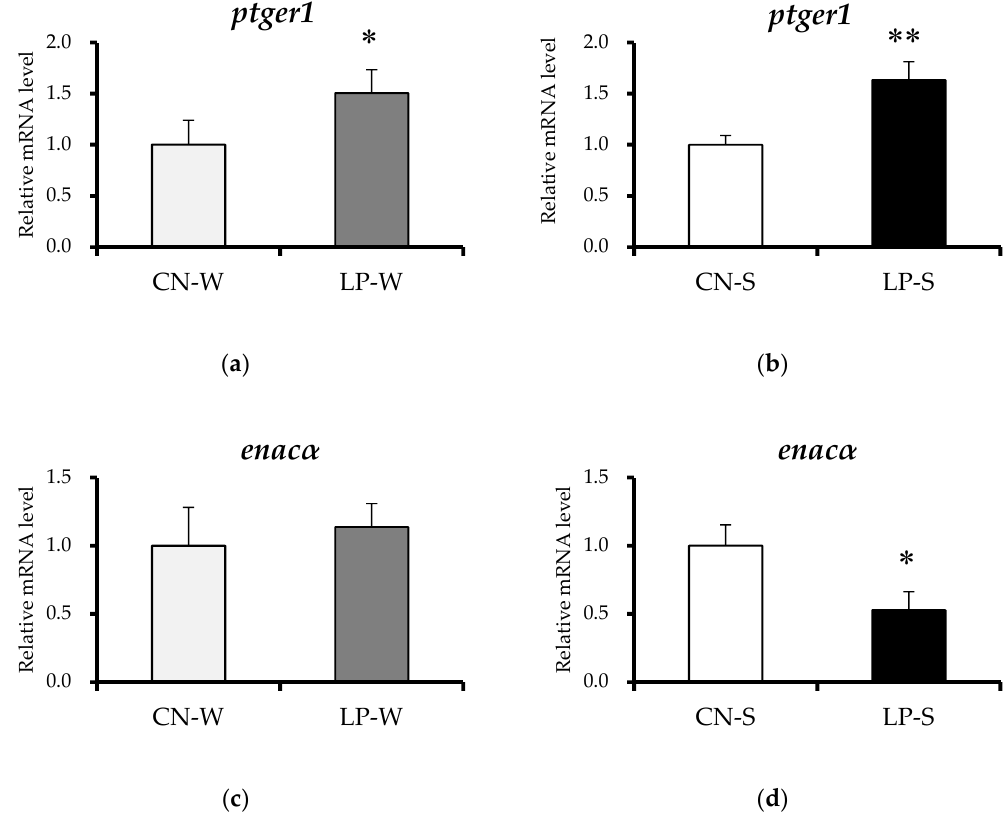
Figure 4. Relative renal expression of ptger1 and enacα mRNA. ( a ) ptger1 mRNA expression levels (Animal experiment 1). ( b ) ptger1 mRNA expression levels (Animal Experiment 2). ( c ) enacα mRNA expression levels (Animal Experiment 1). ( d ) enacα mRNA expression levels (Animal Experiment 2). Values are expressed as the mean ± standard error ( n = 7–8). ** p < 0.01, * p < 0.05 vs. the CN-W or CN-S offspring according to a Student’s t -test. Offspring were exposed to either an intrauterine environment of 20% (CN)-feeding mothers or that of 9% (LP)-Casein diet-feeding mothers, and provided with either water (W) or 1% saline drinking supply (S).